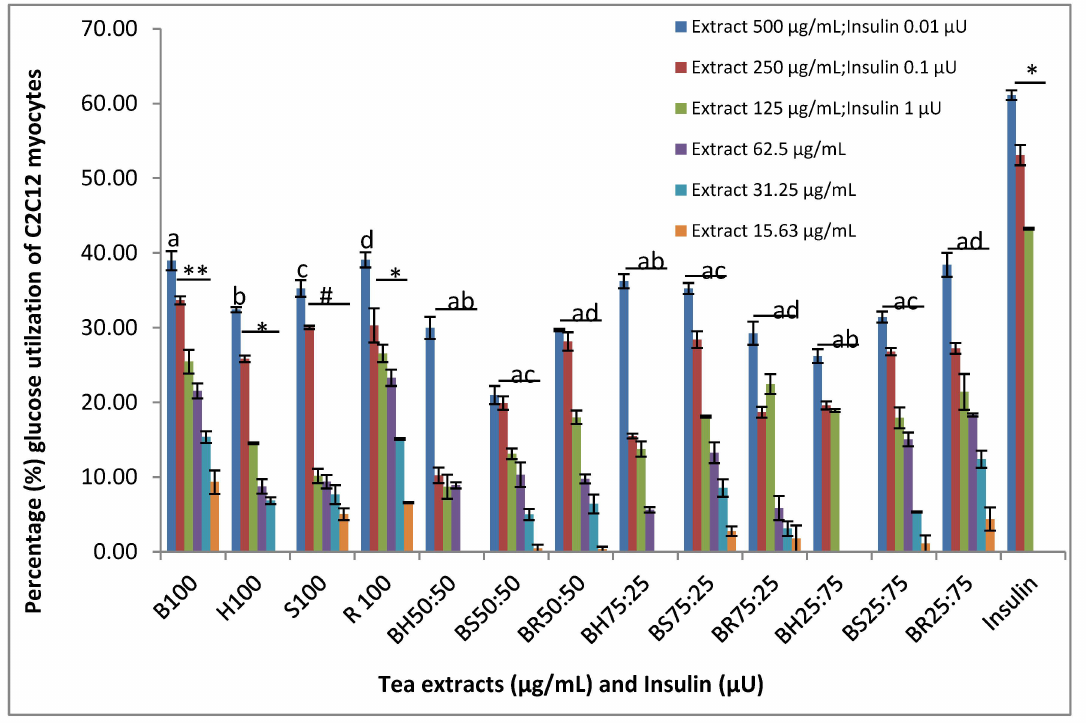
Figure 2. Glucose utilization activity of C2C12 myocytes (expressed as a percentage of untreated control cells ± standard error of the mean, n = 9) exposed to tea extracts and insulin as a positive control (1 µ U = 0.05 µ g/mL). Key: double asterisks indicate statistically significant difference, single asterisks and letters a, b, c, d, indicate significant difference ( p < 0.05) while (#) indicates no significant difference among tea extracts and blend. Whereas a bar beneath symbols (**,*) indicate statistical significance ( p < 0.05) within experimental groups at each point, the one beneath symbol (#) indicates no statistical significance within the experimental group at each point while those beneath letters (a, b, c, d) indicate statistical difference ( p < 0.05) between the data marked by these